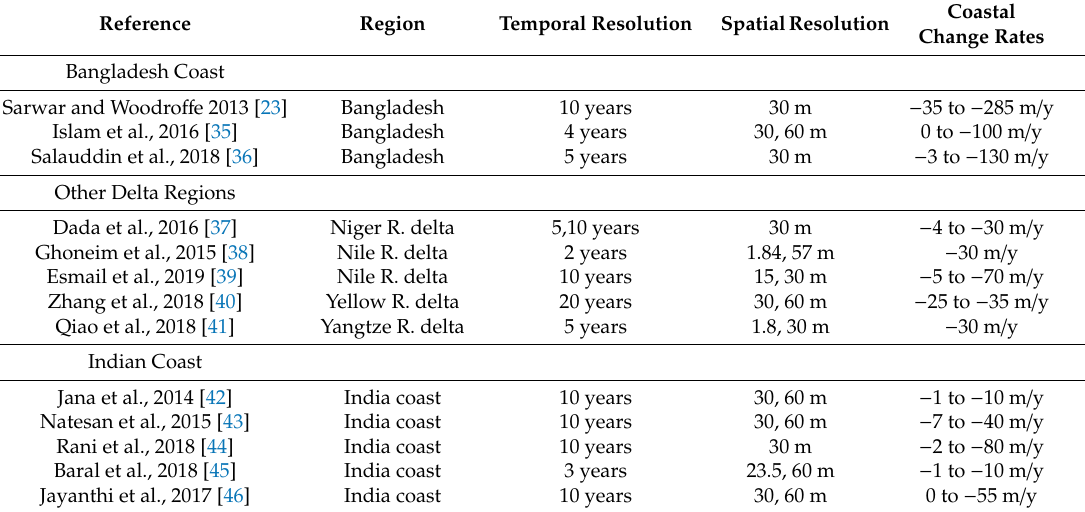
Table 1. Selected coastal erosion rates from different delta and coastal regions.